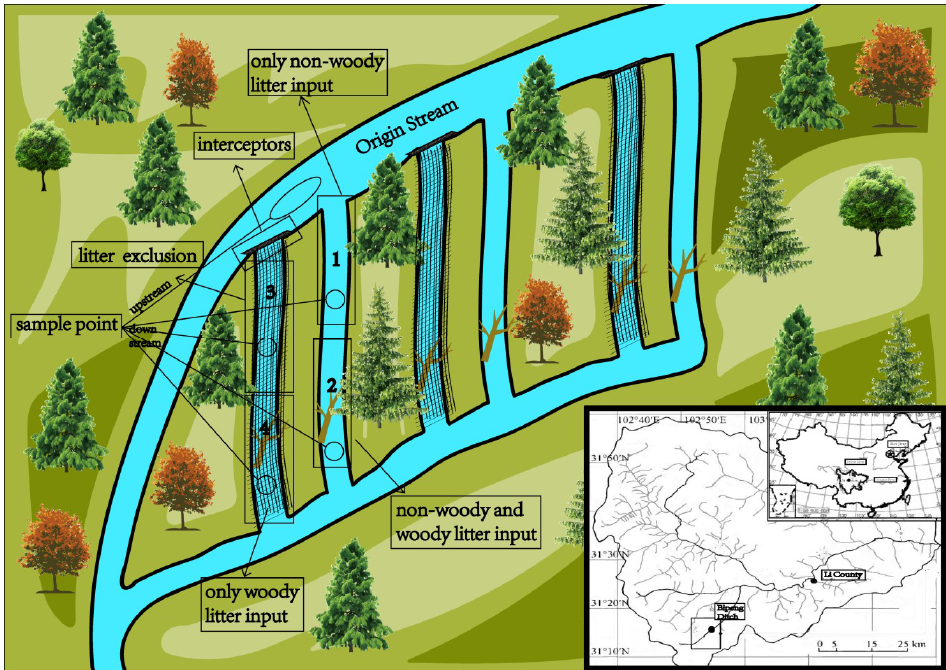
Figure 1. Schematic diagram showing the location and experimental design of our study in the alpine forest.